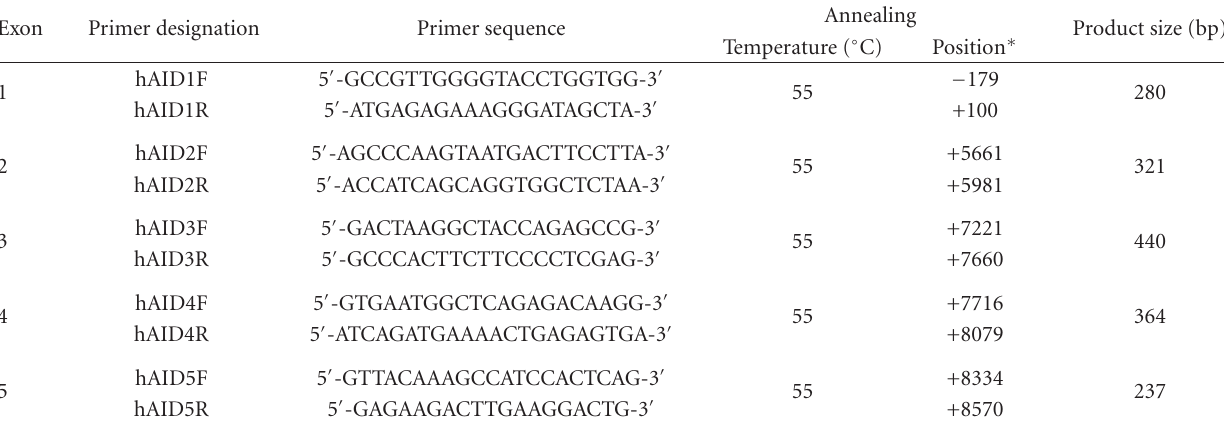
Table 1: AICDA primers, PCR conditions, and size of the fragments used in the study.